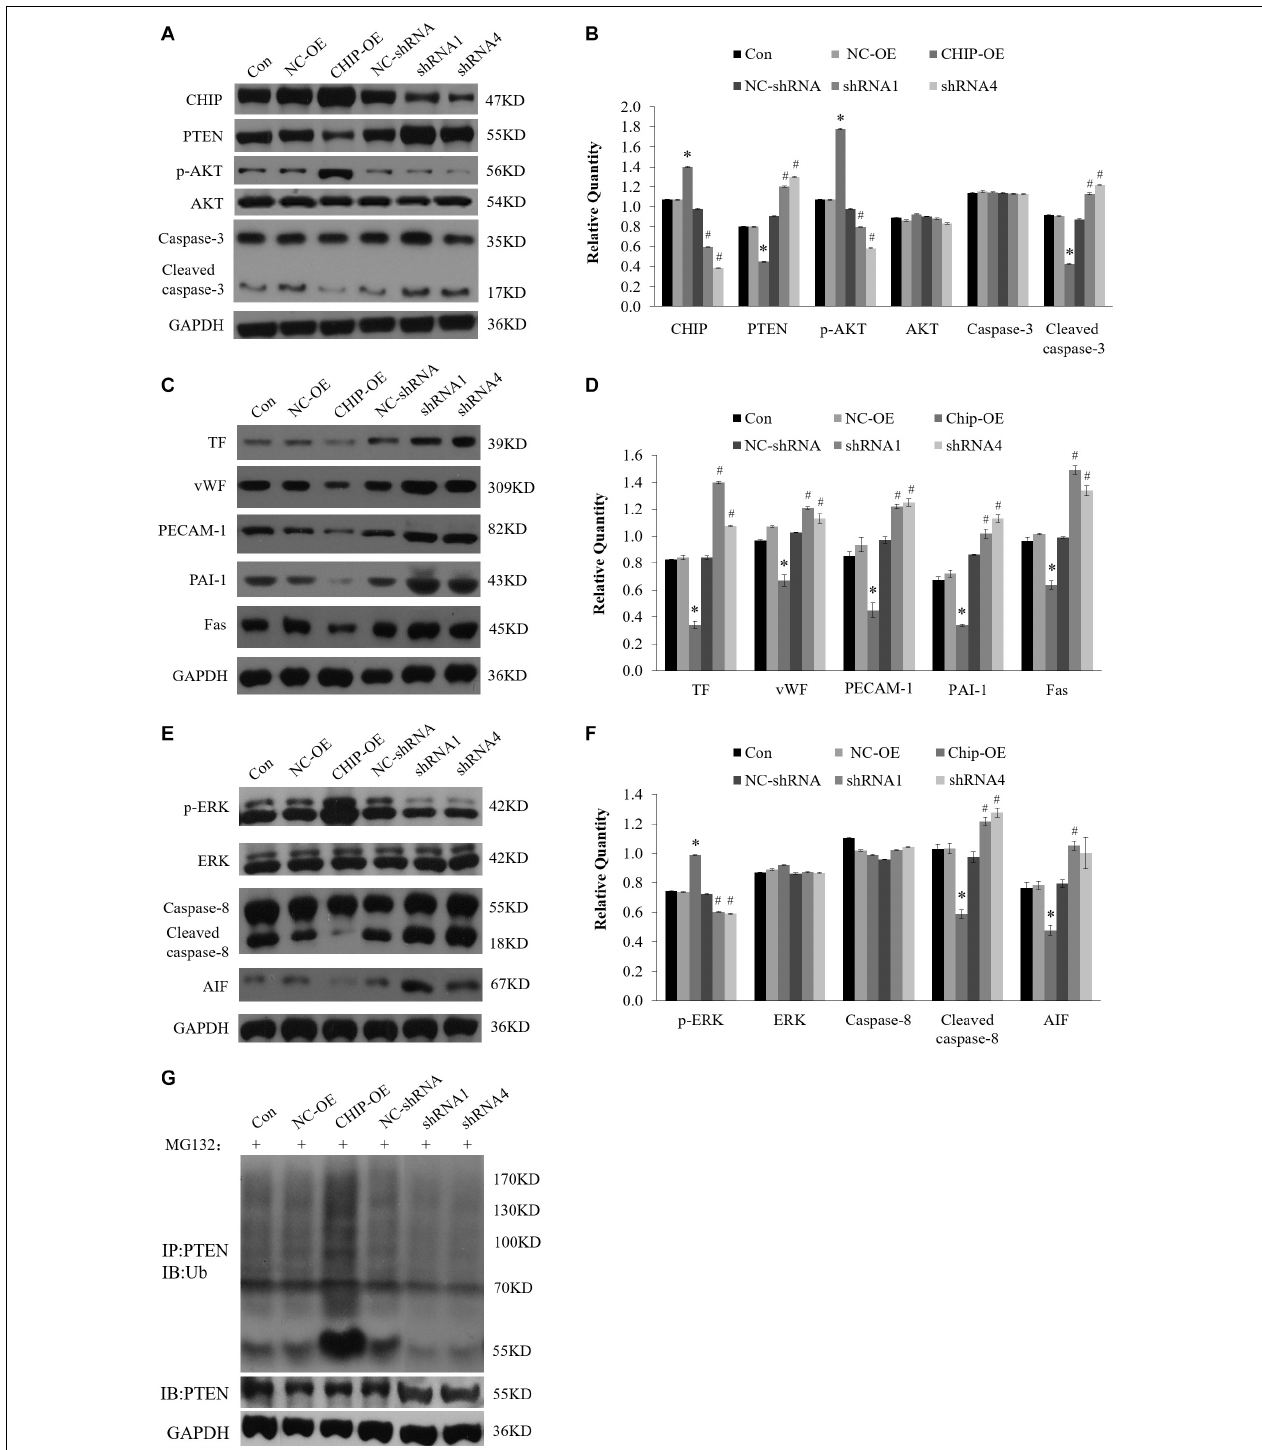
FIGURE 4 | C terminus of Hsc70-interacting protein (CHIP) overexpression attenuated procoagulant and apoptosis molecule expressions after in vitro simulated traumatic brain injury. (A,C,E) Changes of CHIP, PTEN, procoagulant molecules, and apoptosis molecules after in vitro stretch-induced injury treatment. ERK contains ERK1 and ERK2 with the molecular mass of 38–44 kDa; here, the bands of ERK1 and ERK2 were scanned and quantified together as p-ERK/ERK. (B,D,F) Relevant grayscale scanning analysis results of CHIP, PTEN, procoagulant molecules, and apoptosis molecules after in vitro stretch-induced injury treatment. (G) After treatment of MG132 for 12 h, PTEN immunoprecipitation products were tested with immunoblotting. Quantification of proteins was normalized to glyceraldehyde-3-phosphate dehydrogenase. ∗ p < 0.05 vs. the NC-OE, # p < 0.05 vs. the NC-shRNA.